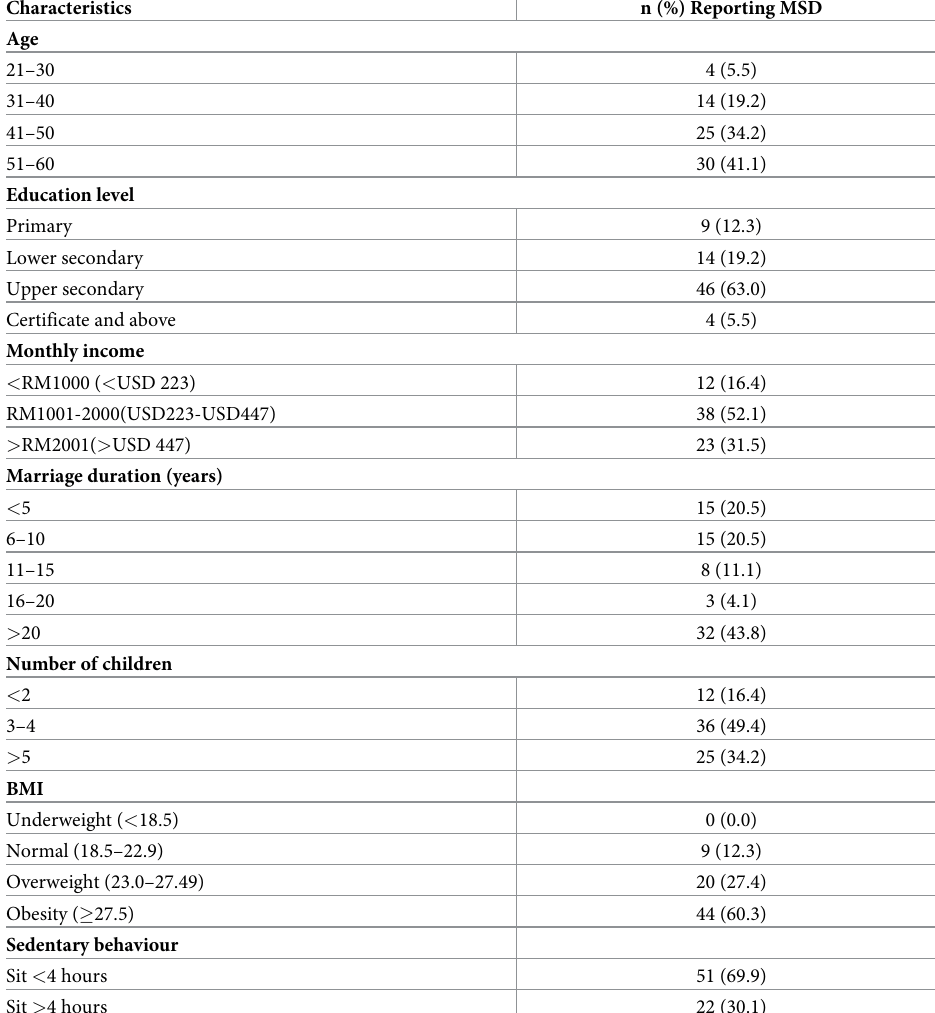
Table 1. Percentages of the housewives reporting MSD according to socio-demographic factors (n =